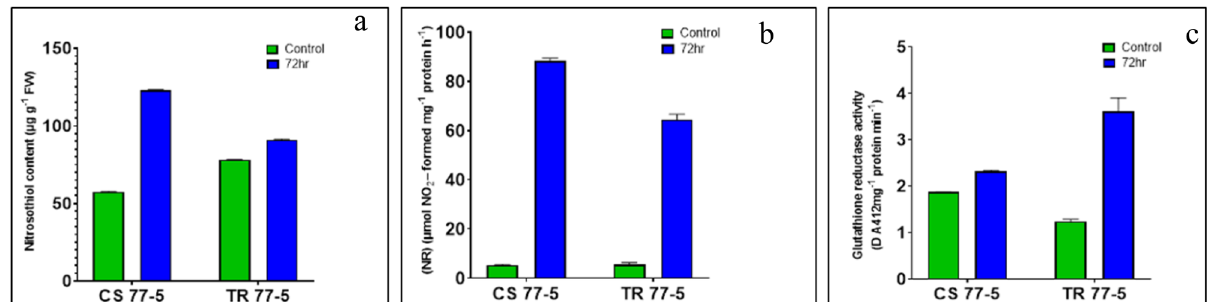
Figure 9. Effects of leaf rust pathogen on NO production Nitrosothiol accumulation ( a ) Nitrate reductase activity ( b ) and glutathione reductase activity ( c ) activity in leaves of wheat seedlings. Wheat genotypes Chinese spring (CS) (susceptible) and transfer (TR) (resistant line) inoculated with leaf rust pathotype 77-5. Samples were collected at 72 h after inoculation (HAI) and from uninoculated plants (C). Values are means (± SE) of 3 biological replicates. Graphs were created in Graph Pad prism 8 (www. graph pad.